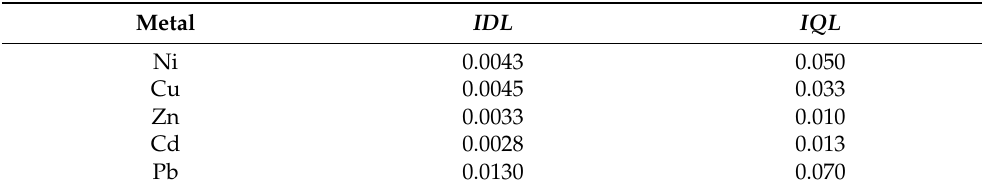
Table 2. Comparison of measured and certified concentrations in BCR-482 lichen . BCR-482 lichen AAS Dev .** (Certified) (Measured) Metal Concentration ± Uncertainty Mean ± SD * [mg/kg dry weight] [%] Ni 2.47 0.07 2.16 0.32 − 13 Cu 7.03 0.19 6.63 0.17 − 5.7 Zn 100.6 2.2 95.1 2.3 − 5.5 Cd 0.56 0.02 0.53 0.03 − 5.3 Pb 40.9 1.4 38.2 1.0 −